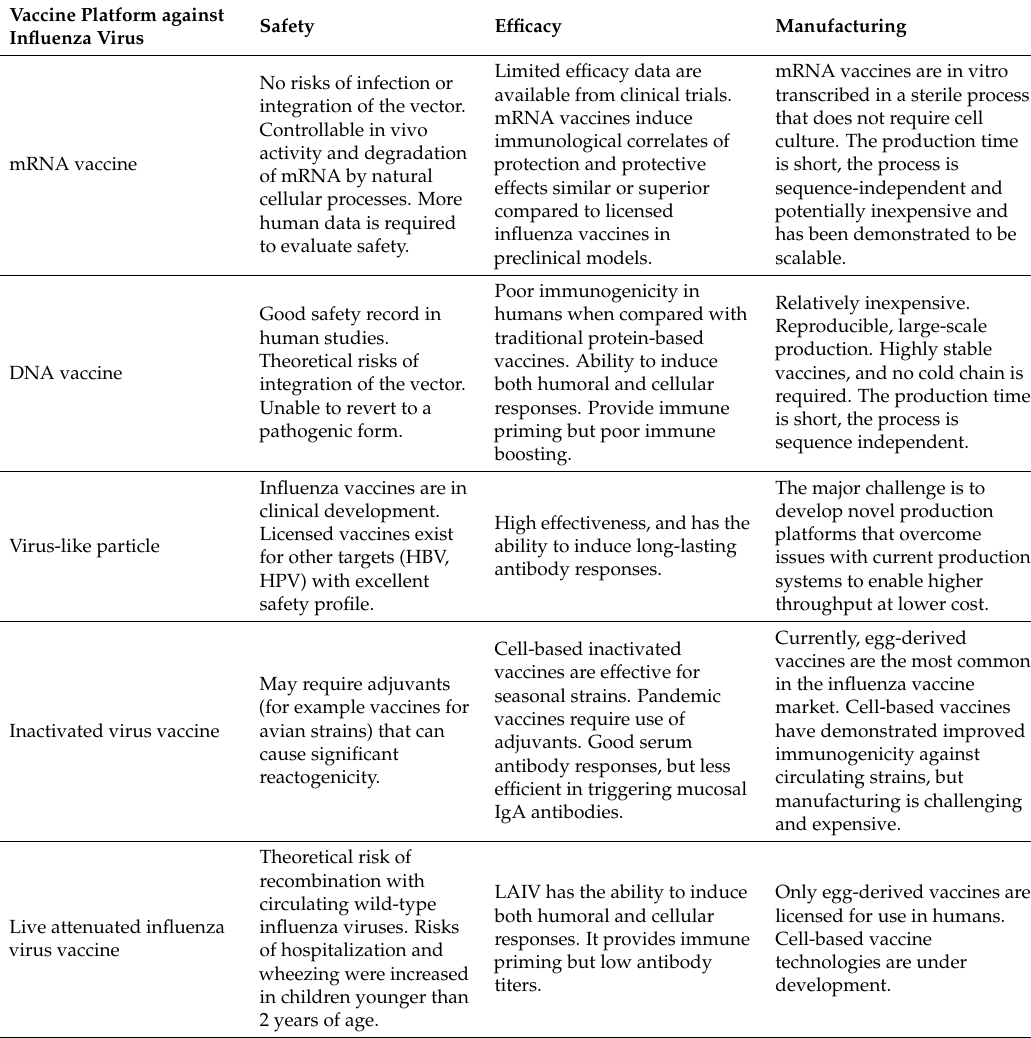
Table 2. Main characteristics of various influenza vaccine